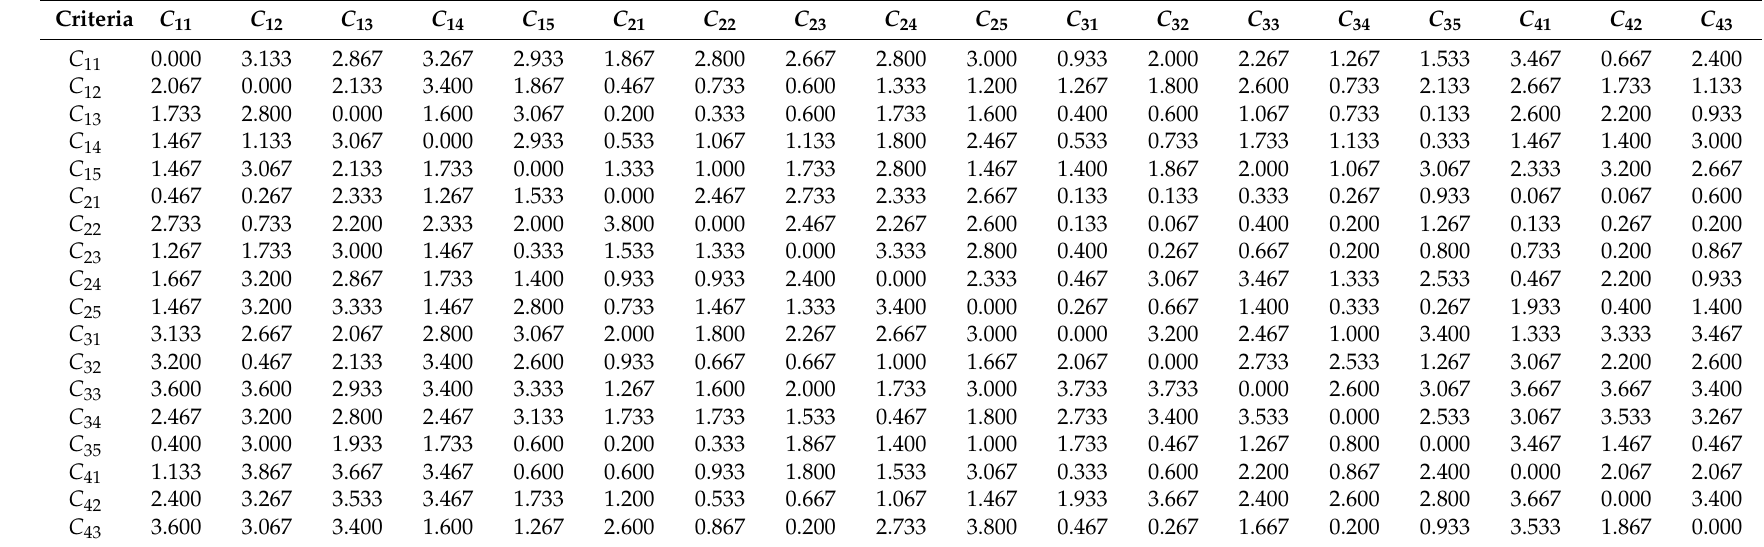
Table A1. Initial influence matrix A